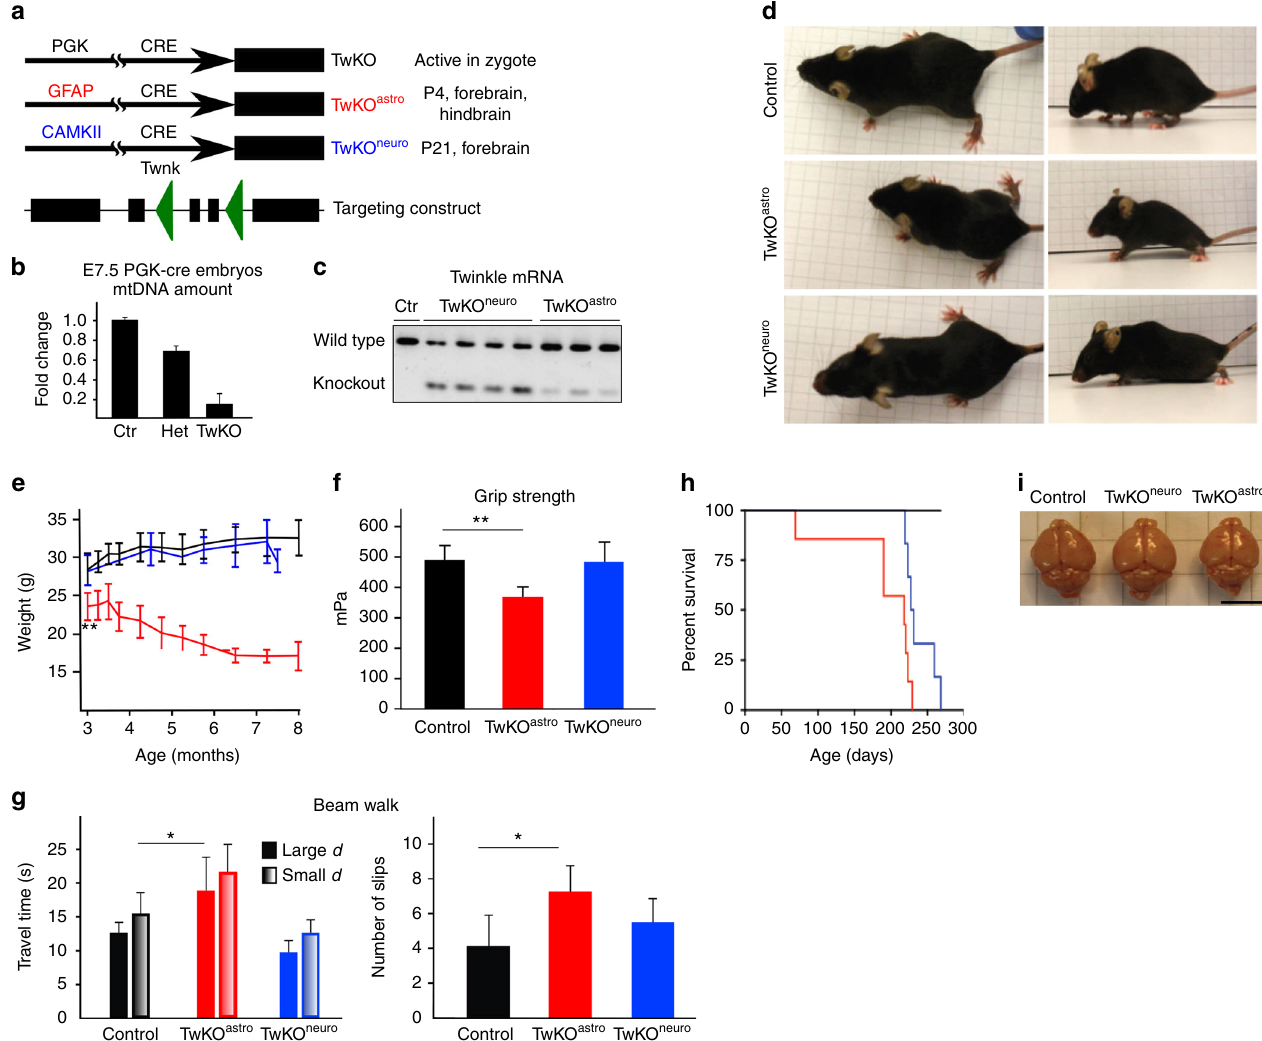
Fig. 1 Knockout of mtDNA maintenance in astrocytes causes early-onset neurodegenerative disease. a Cre- promoters and timing of activation (PGK = phosphoglycerate kinase, GFAP = glial fi brillary-acidic-protein, CaMKII = calcium/calmodulin-dependent protein kinase-II). Targeting construct: Boxes = exons, triangles = LoxP sites. b MtDNA amount in constitutive Twinkle knockout (TwKO), embryonal day 7.5 (Ctr = control, Het = heterozygote; TwKO = homozygous). c Size of Twinkle-cDNA in TwKO lines; cerebral cortex. d TwKO mouse phenotypes at the age of 6 months. TwKO astro mice: small, paraparetic posture. TwKO neuro mice are control-like. e Body weight progression: red = TwKO astro , blue = TwKO neuro , black = Control. ** p < 0.01 for the fi rst time-point; subsequent time-points p < 0.05. f Automated grip strength test for forelimbs (6 months of age). g Beam walk test for motor coordination (large d = large diameter, small d = small diameter beam). h Kaplan – Meier survival curves. Red = TwKO astro , blue = TwKO neuro , black = Control. i Brains of TwKO astro , TwKO neuro , and Control mice are similar. Scale bar is 0.5 cm. The data are presented as mean and error bars indicate standard deviation. Statistical signi fi cance: * p < 0.05, ** p <